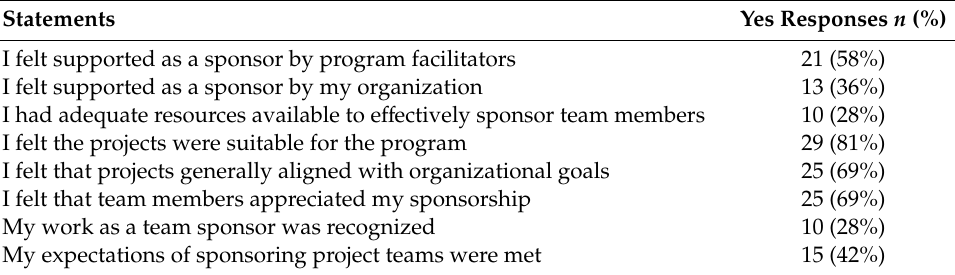
Table 5. Experiences of executive sponsors ( N =